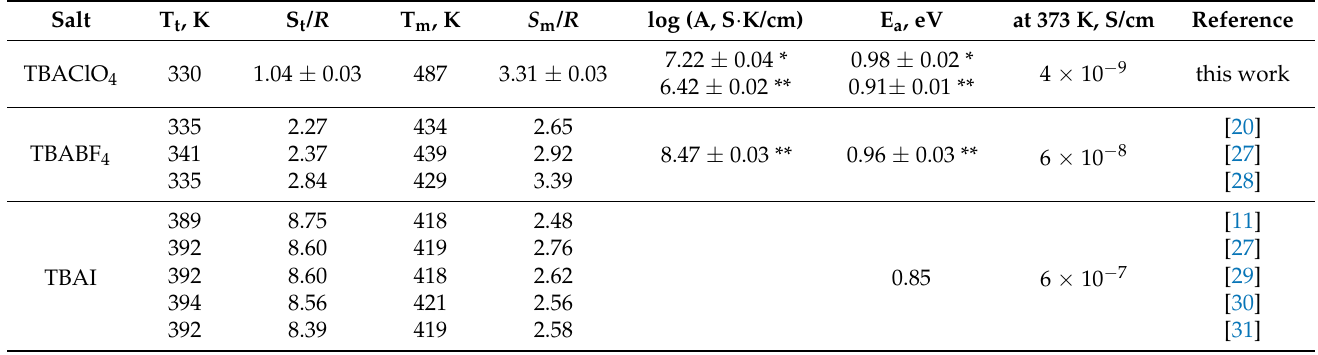
Table 1. The thermodynamic parameters of phase transitions and conductivity data for TBA salts having isostructural HT